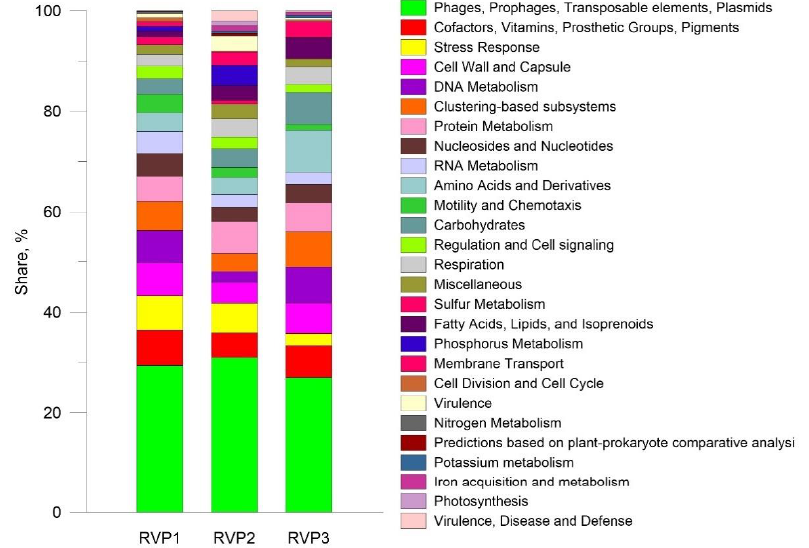
Figure 5. Functional annotations of the RVP1, RVP2, and RVP3 transcriptomes by SEED subsystems. Most viral transcripts were assigned to the category “ Phages, Prophages, Transpos- able elements, Plasmids ” , RVP1-29.4%, RVP2-31%, RVP3-27%. This category included dis- covered proteins such as phage terminase large subunit, integrase, exonuclease, major capsid protein, tail fibre protein, endolysin, etc. The second largest group in RVP1 was “ Cofactors, Vitamins, Prosthetic Groups, Pigments ” (7%). This category includes the most numerous proteins: probable iron binding protein from the HesB IscA SufA family and